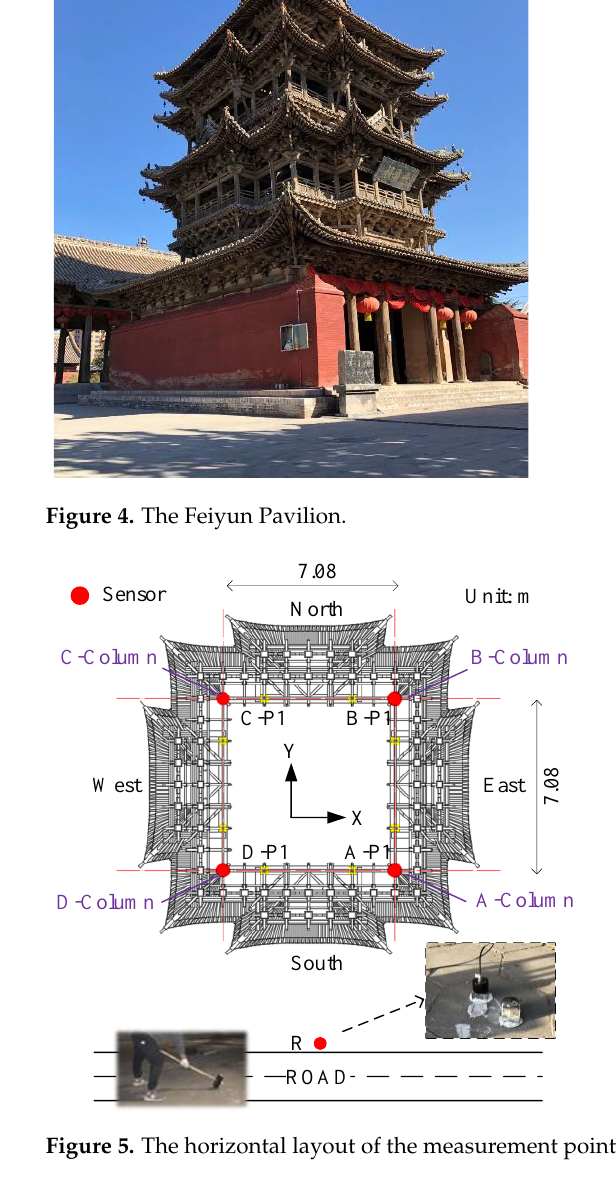
Figure 5. The horizontal layout of the measurement points. (Field Test of the RTR Function).